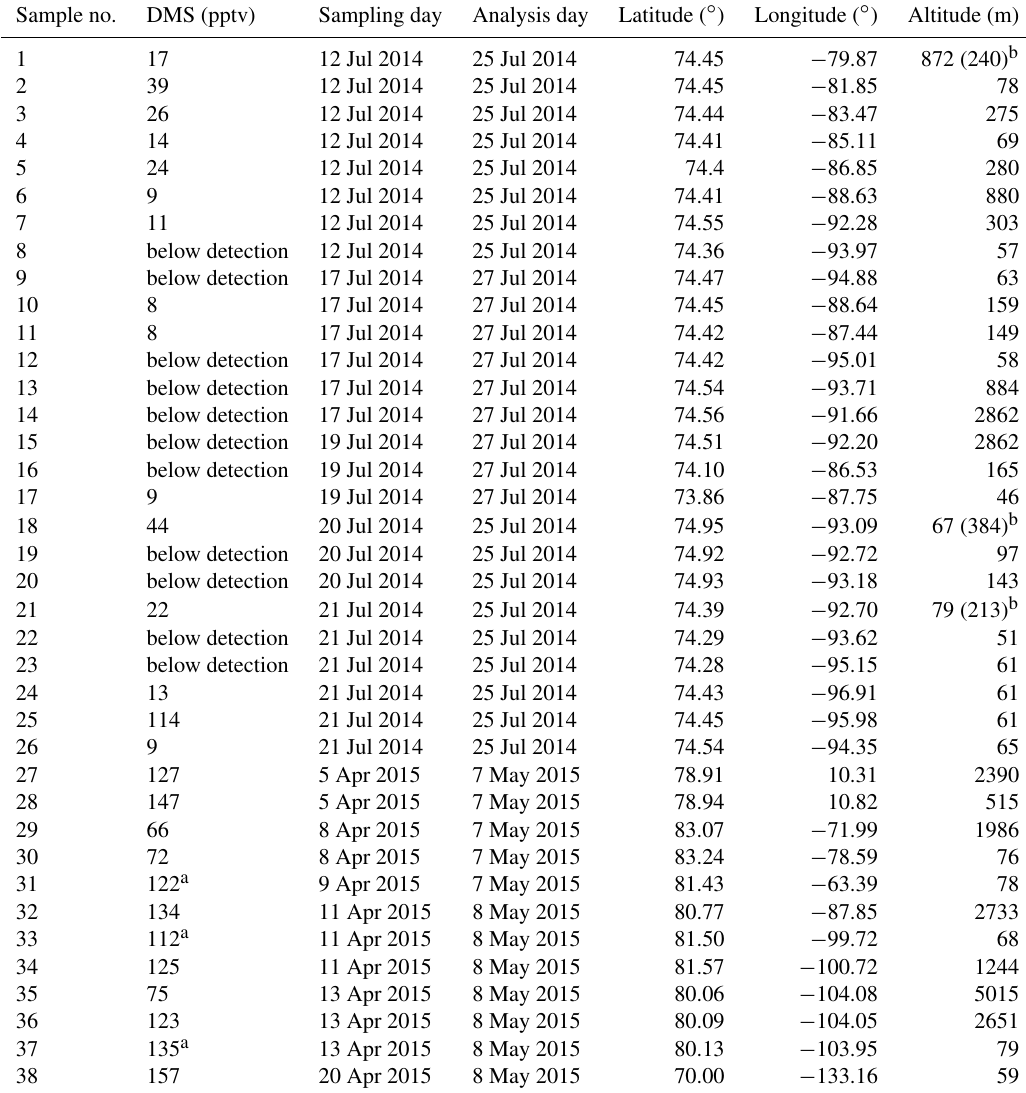
Table 1. DMS mixing ratio values, sampling/analysis dates and sampling locations for July 2014 and April 2015. Sample